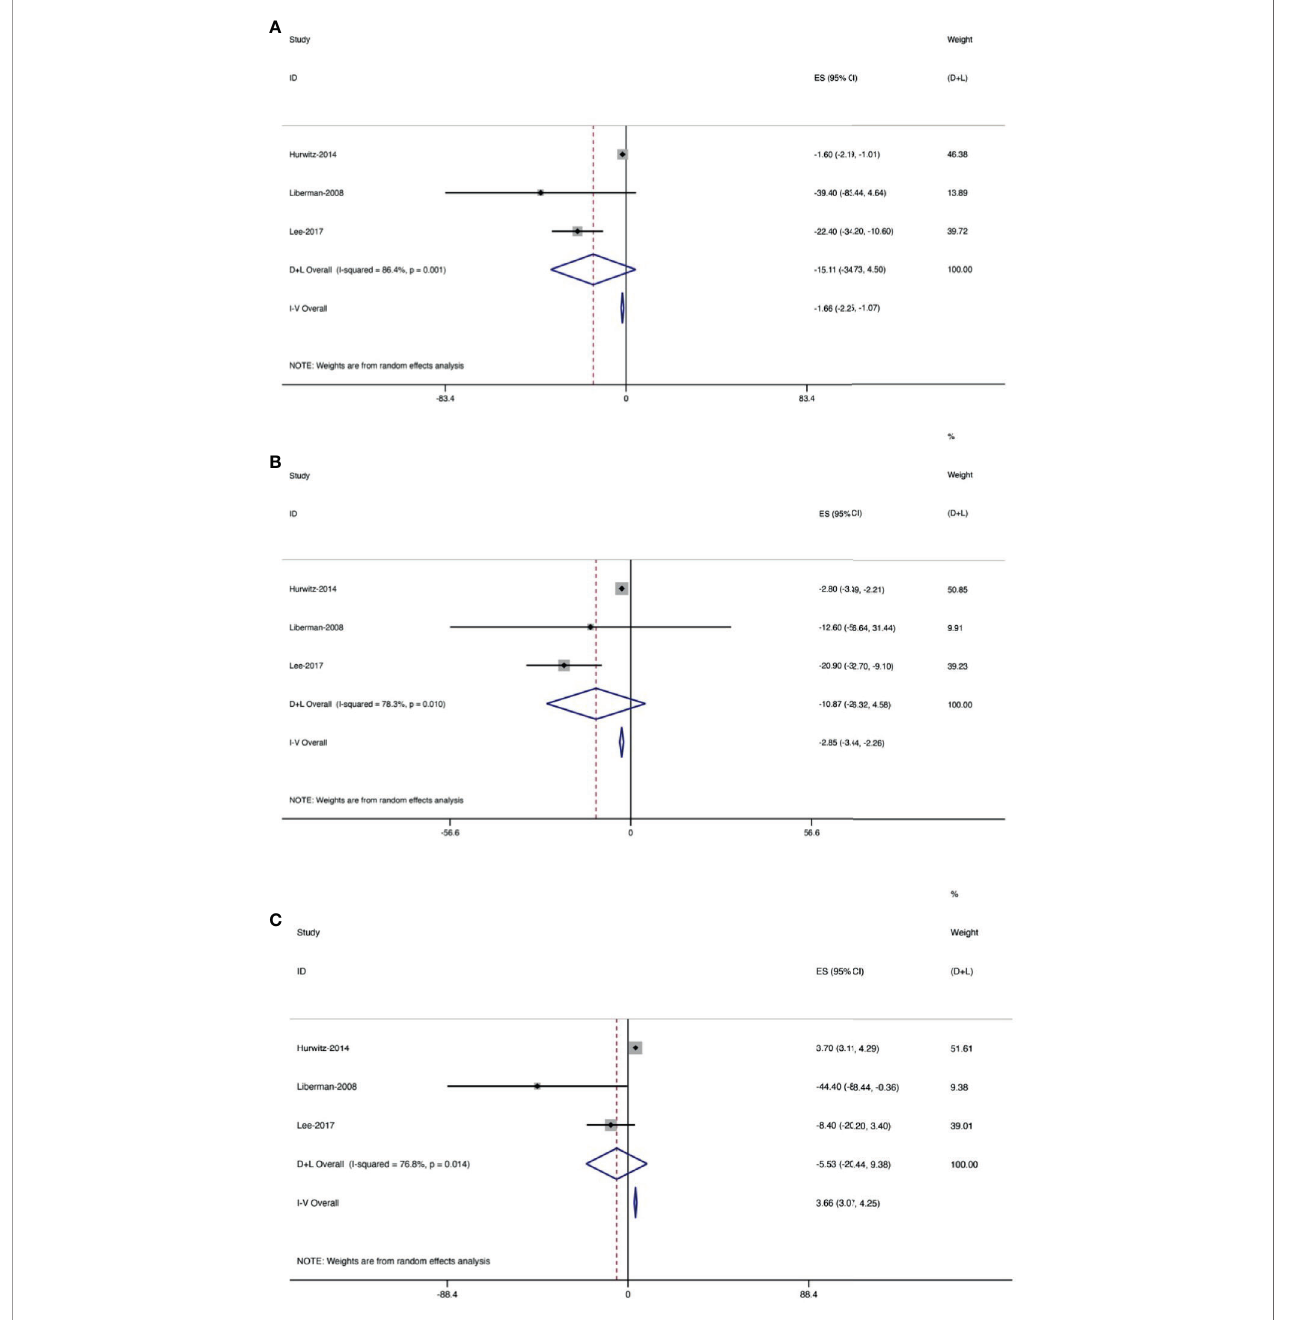
FIGURE 6 | Forest plot for changes from baseline in the oral morphine equivalent dose (OMEDD) at each evaluation point after treatment of patients with bone metastases. (A) At 2 weeks. (B) At 1 month. (C) At 3